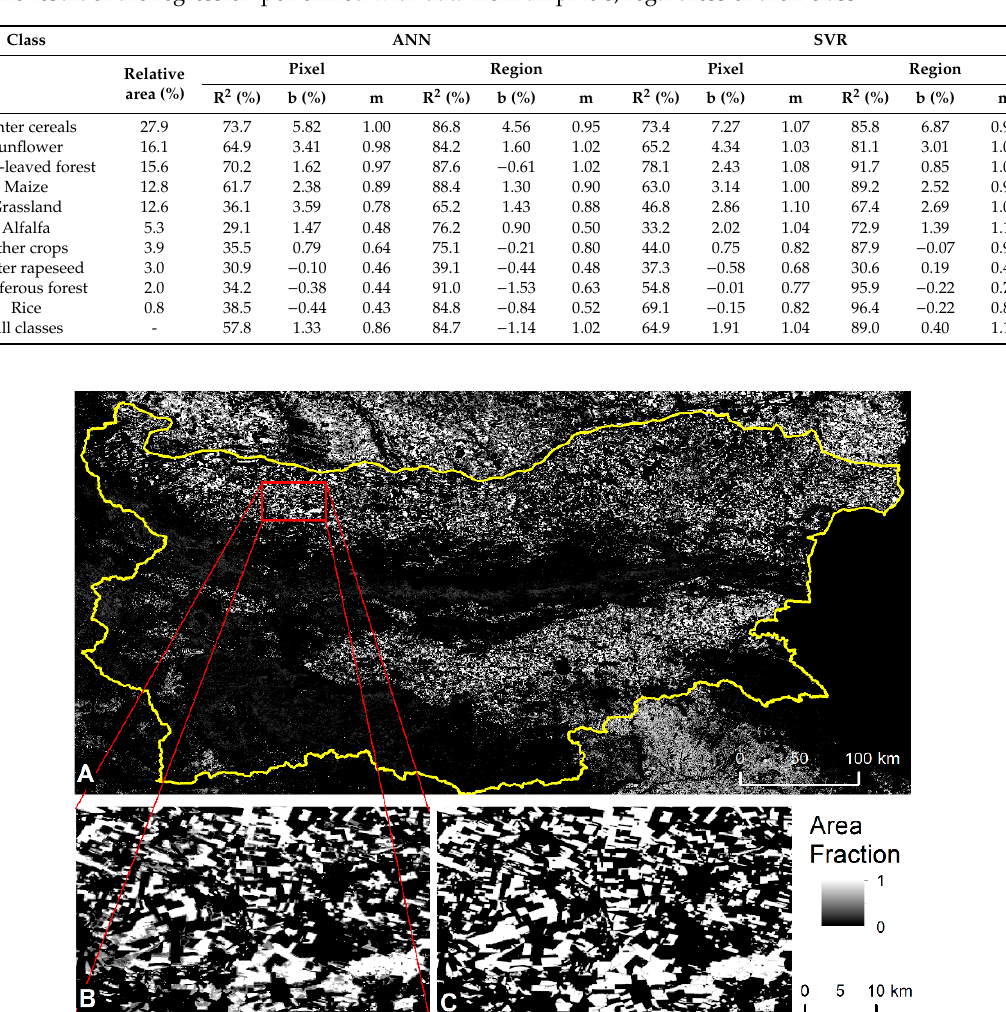
Figure 5. ( A ) Estimated area fraction image for the winter cereals class derived by the artificial neural network (ANN) sub-pixel classification of PROBA-V 100 m normalized difference vegetation index (NDVI) time series over Bulgaria. ( B ) Excerpt from the image in (A) for part of “Knezha” test site. ( C ) True area fraction image for the same region as (B) derived from the reference Sentinel-2 classification.